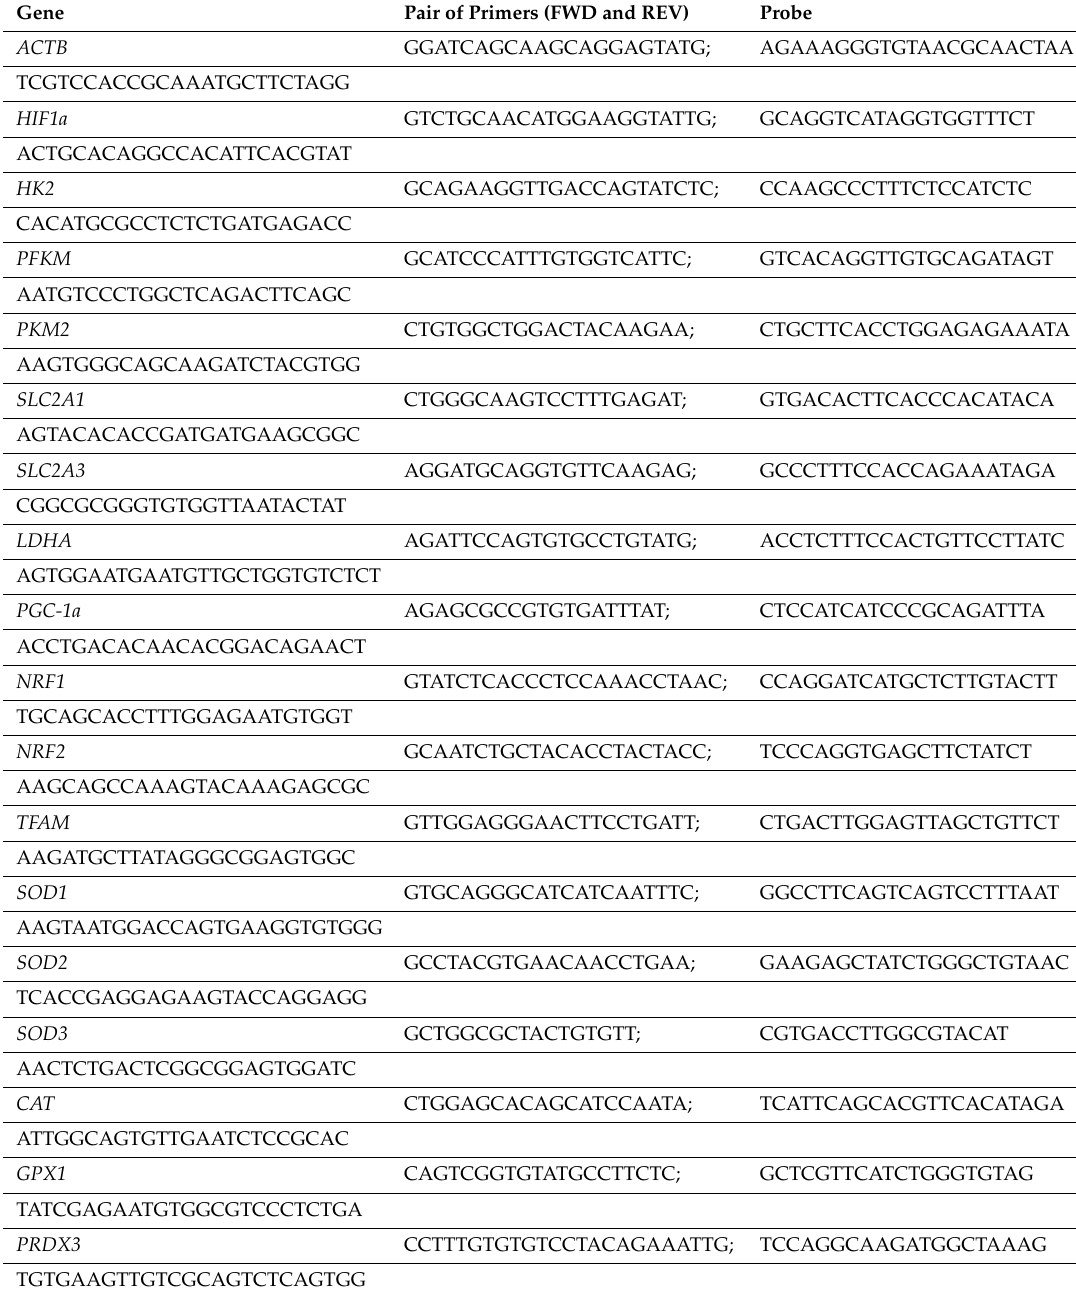
Table 4. List of primer and probe sequences for